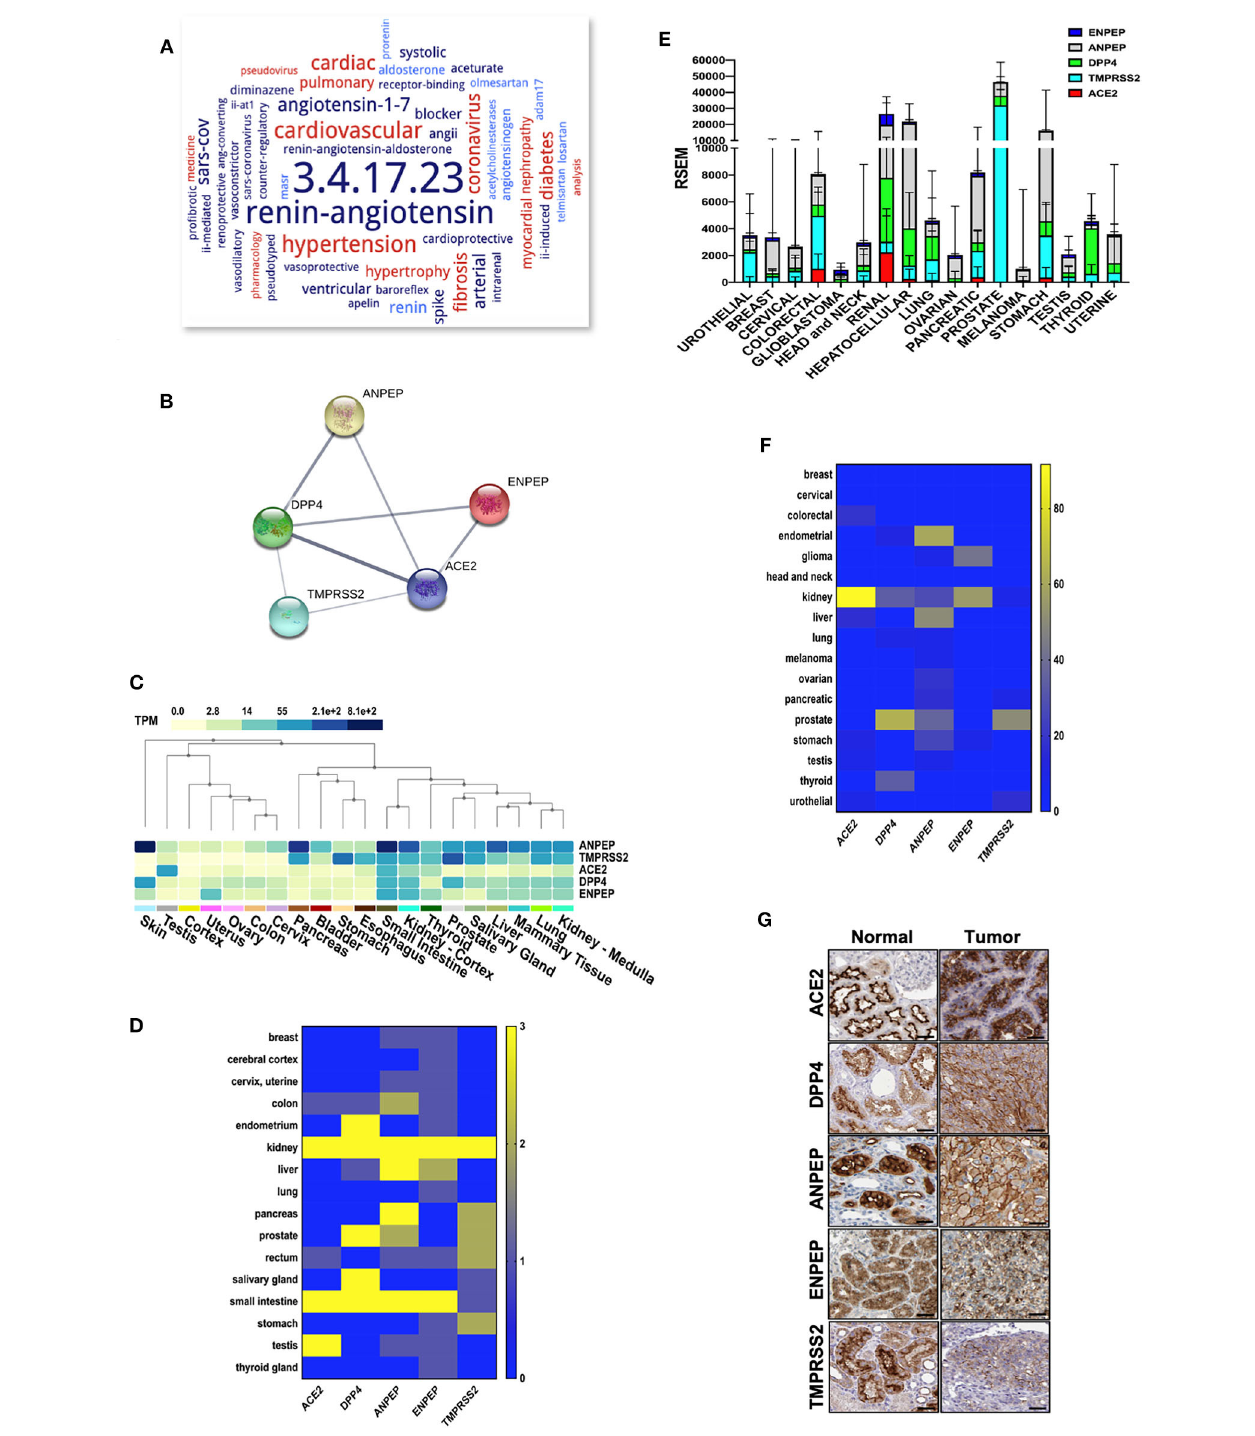
FIGURE 1 | Expression of coronavirus receptors in human tissues. (A) The word cloud of various attributes associated with ACE2. Analysis identified the ACE2 enzyme functions and related disorders with the most prominent one appearing larger than the remaining words (B) All coronavirus receptors (ACE2, DPP4, TMPRSS2, ANPEP, and ENPEP) were used with high confidence (0.8) evidence from experimental protein–protein interaction (blue lines) databases for STRING analysis. Each Node labeled with the encoding gene symbol represents a protein. (C) Heatmap of mRNA expression extracted from the GTEx database for coronavirus receptors in various human normal tissues and organs ( n = 8,587). Kidney and small intestine tissues showed enriched mRNA expression of coronavirus